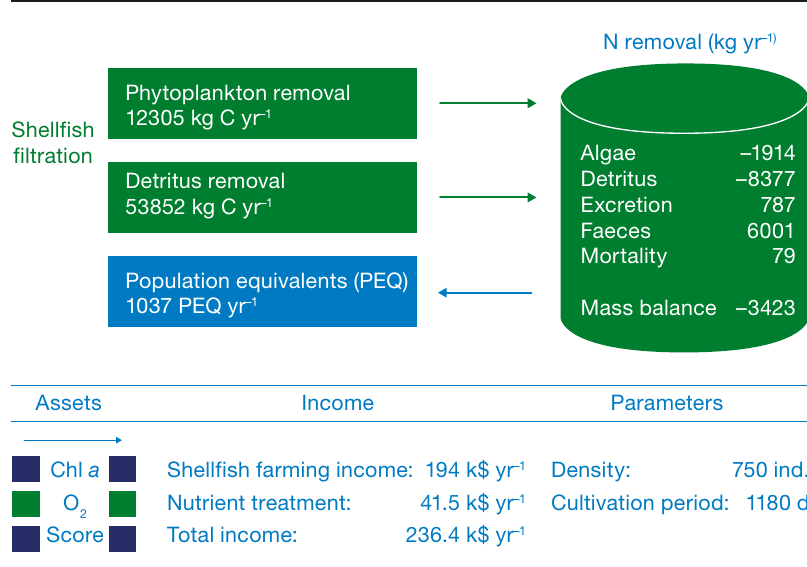
Fig. 8. FARM model annualized mass balance for Manila clam culture at Chuckanut Shellfish farm (the seaweed fouling component is not